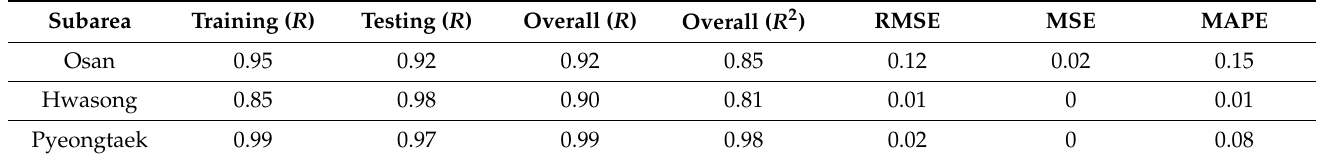
Table 2. Results of training and testing values for the ANN